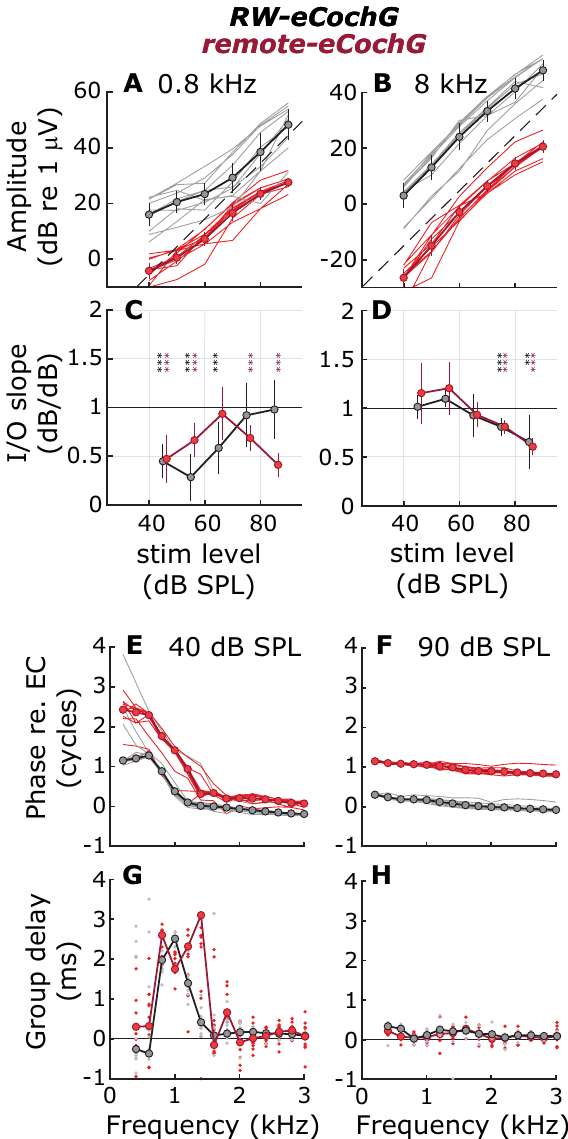
Figure 2. Level dependence, phase, and group delays for RW-eCochG and remote-eCochG in normal ears. ( A , B ) Input and output (I/O) curves of RW-eCochG ( black ) and remote-eCochG ( red ) amplitude in n = 10 animals at two stimulus frequencies. Error bars give 95% confidence intervals around the mean ( circles ). The slopes of these I/O curves are shown in ( C , D ), where a slope of 1 dB/dB and < 1 dB/dB represents linear and compressive nonlinear growth with SPL, respectively. At each stimulus level, a t-test was used to assess whether the slope was significantly smaller than unity. Asterisks indicate the probability with: ** p < 0.01; *** p < 0.005. A small horizontal offset between RW- and remote-eCochG responses was introduced for clarity. ( E , F ) Phase- vs-frequency curves for the same n = 10 animals at two different stimulus levels. ( G , H ) Corresponding group delays. Both individual ( thin lines/small dots ) and average ( circles ) are